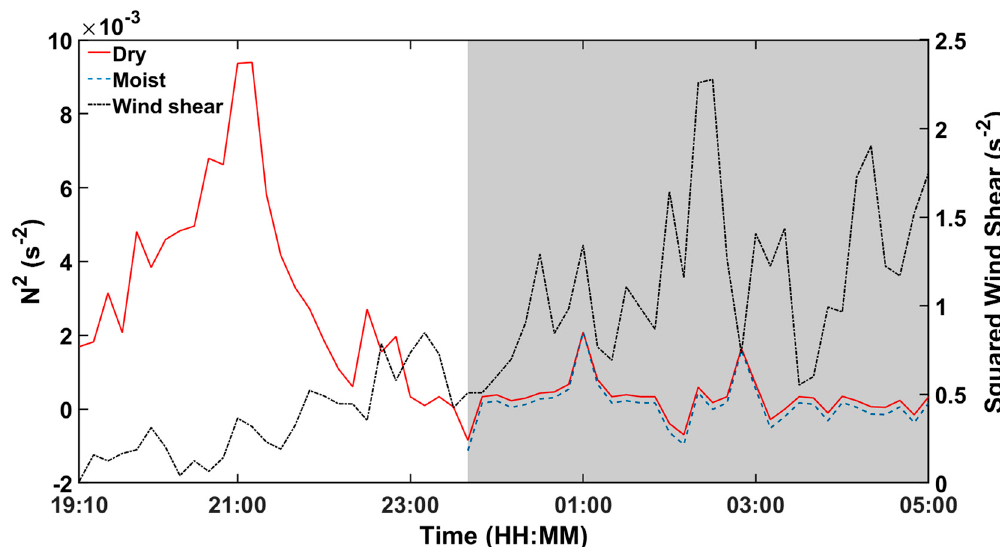
Figure 3. The time series of squared Brunt–Vaisala frequency (BVF) (N 2 ) for dry air (red), for saturated air (blue), and squared vertical shear of horizontal wind (black) for 1900 08 Oct. 2017–0500 09 Oct. 2017 in Case 4. The gray shading indicates the fog layer. The BVF is calculated between the 3- and 5.1-m levels using 10-min averages of the WXT and AWS data. For saturated air, FM-120 data at 2 m level are used to calculate liquid water mixing ratio. We assume saturated conditions when the visibility at 2.3 m level is less than 1000 m. The vertical shear of the horizontal wind is calculated between the 3- and 5.1- m levels using 10-min averages of WXT data.